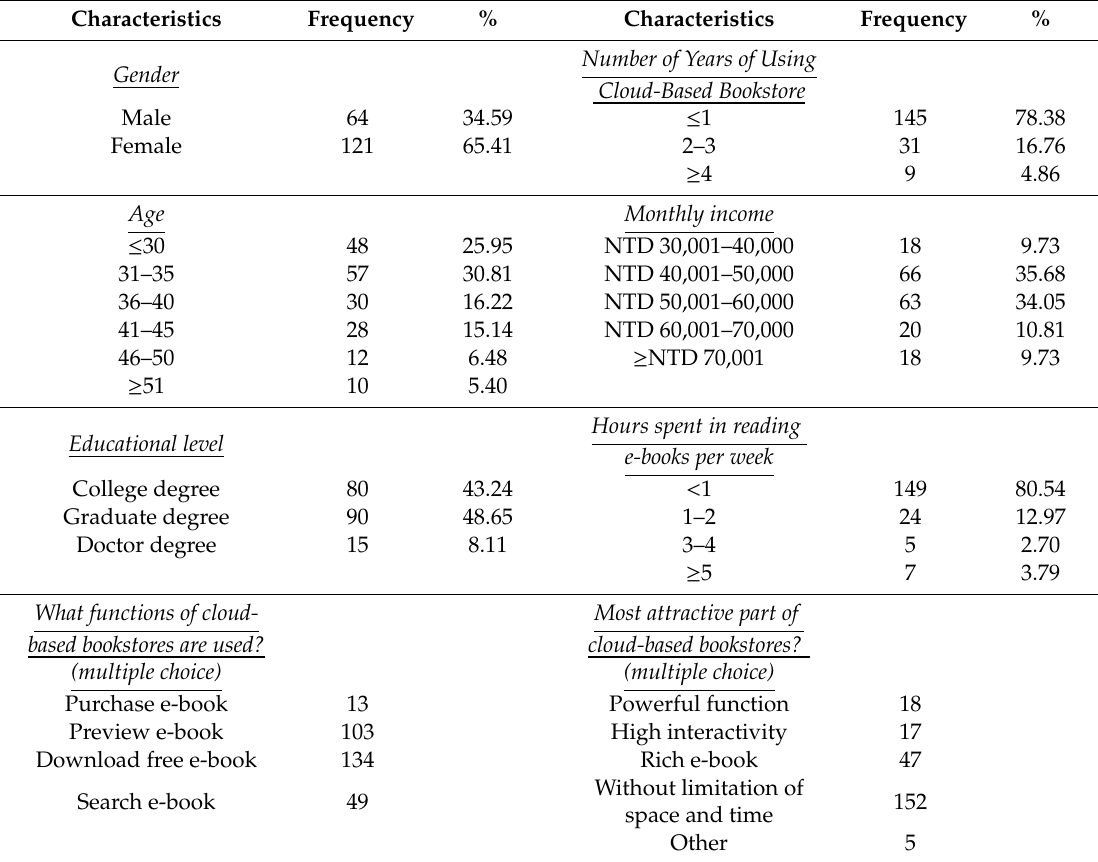
Table 3. Results of demographic